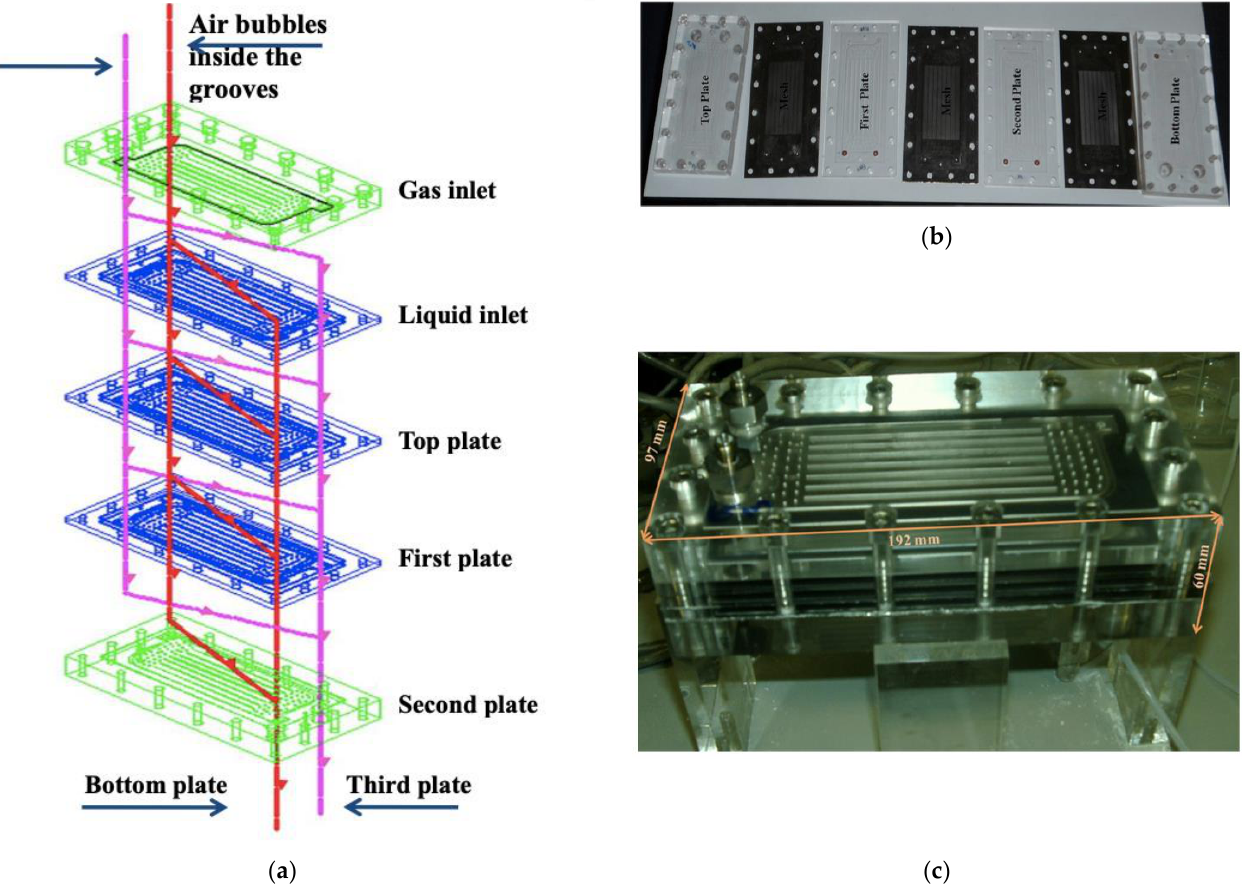
Figure 3. ( a ) Scale-out metallic mesh reactor’s flow configuration ( b ) Picture of the components of the scale out metallic mesh reactor ( c ) Picture of assembled scale out metallic mesh reactor.